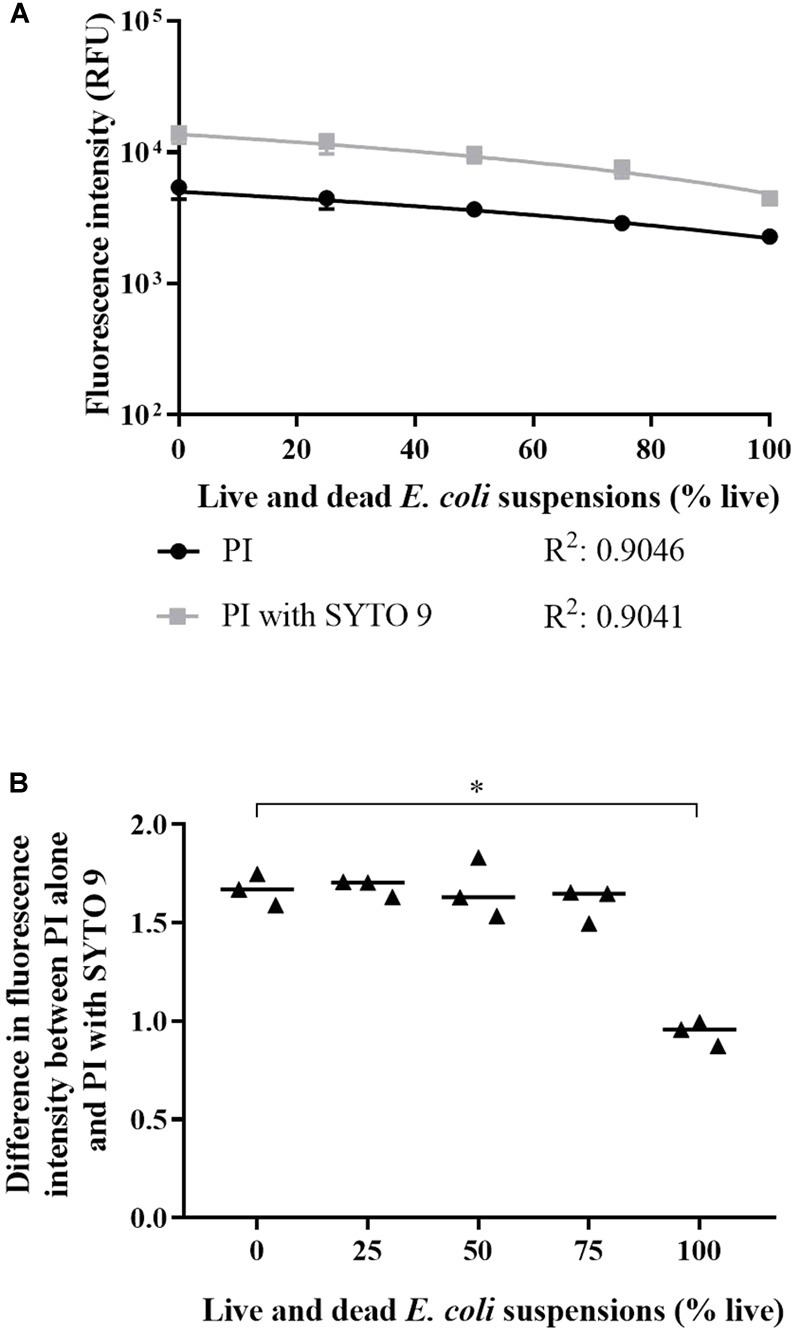
Interaction between SYTO 9 and PI. (A) Fluorescence intensities at 600–610 nm from live and dead E. coli suspensions in minimal media stained with PI alone (circles) and PI with SYTO 9 (squares). A line of best fit for each staining condition was generated using a linear regression analysis and significant difference between conditions was determined using an ANCOVA. The slopes of the lines were significantly different (P-value: <0.05). Data presented is the median with the range from three biological replicates. (B) The absolute difference in fluorescence intensity between E. coli stained with PI alone and PI with SYTO 9 normalised to PI alone. Statistical significance is represented by ∗ (Kruskal-Wallis test, P-value: <0.05, Dunn’s multiple comparison post hoc test). Data presented is from three biological replicates with a median line.